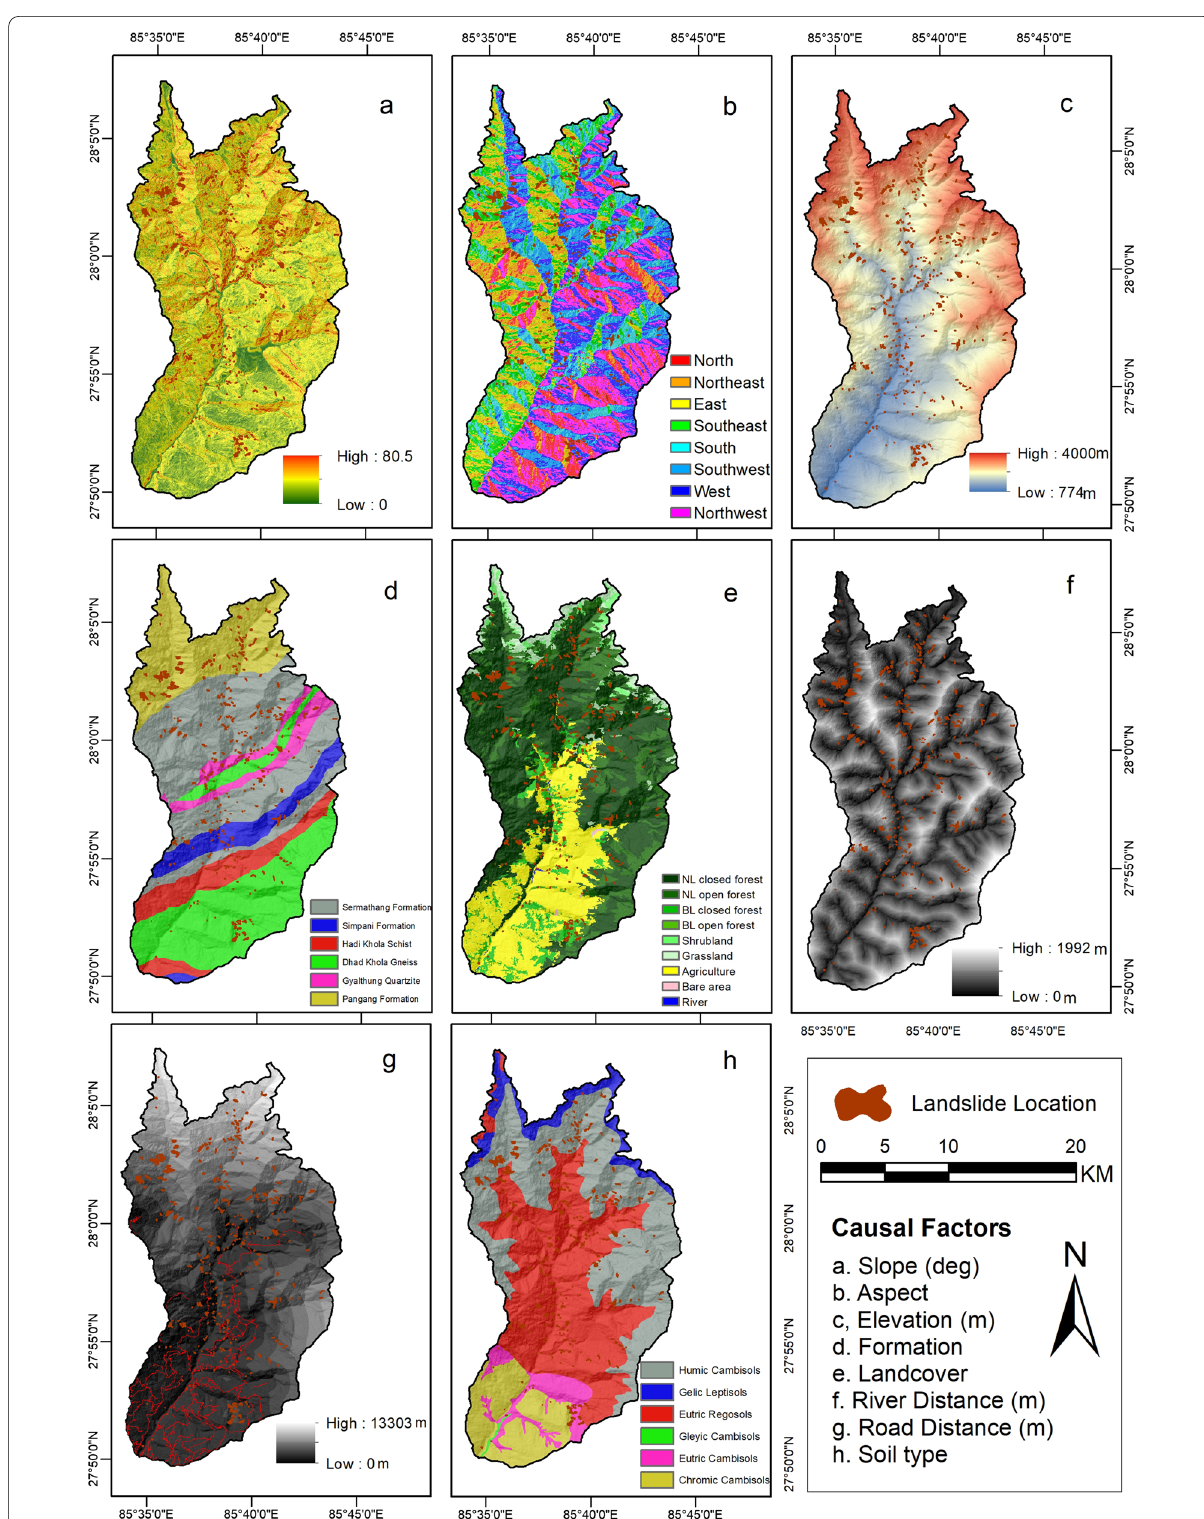
Fig. 2 a Landslide causative factor’s map of the study area. b Landslide causative factor’s map of the study